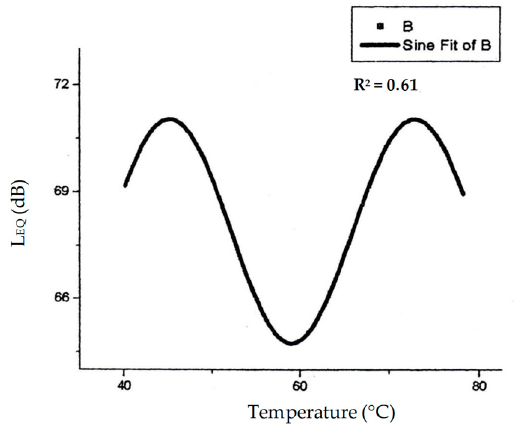
Figure 10. Correlation modeling between Temperature and Noise Level at OW-L.